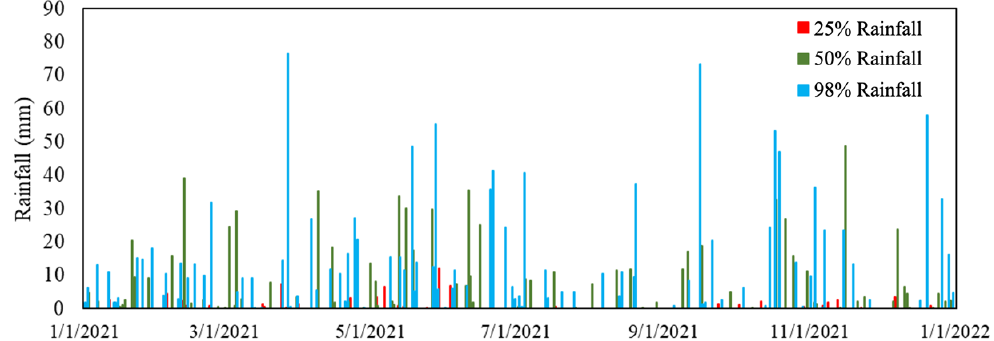
Figure 5. Synthetic rainfall time series generated by the overland erosion model for the Wilson Creek bridge construction site, Texas, U.S.